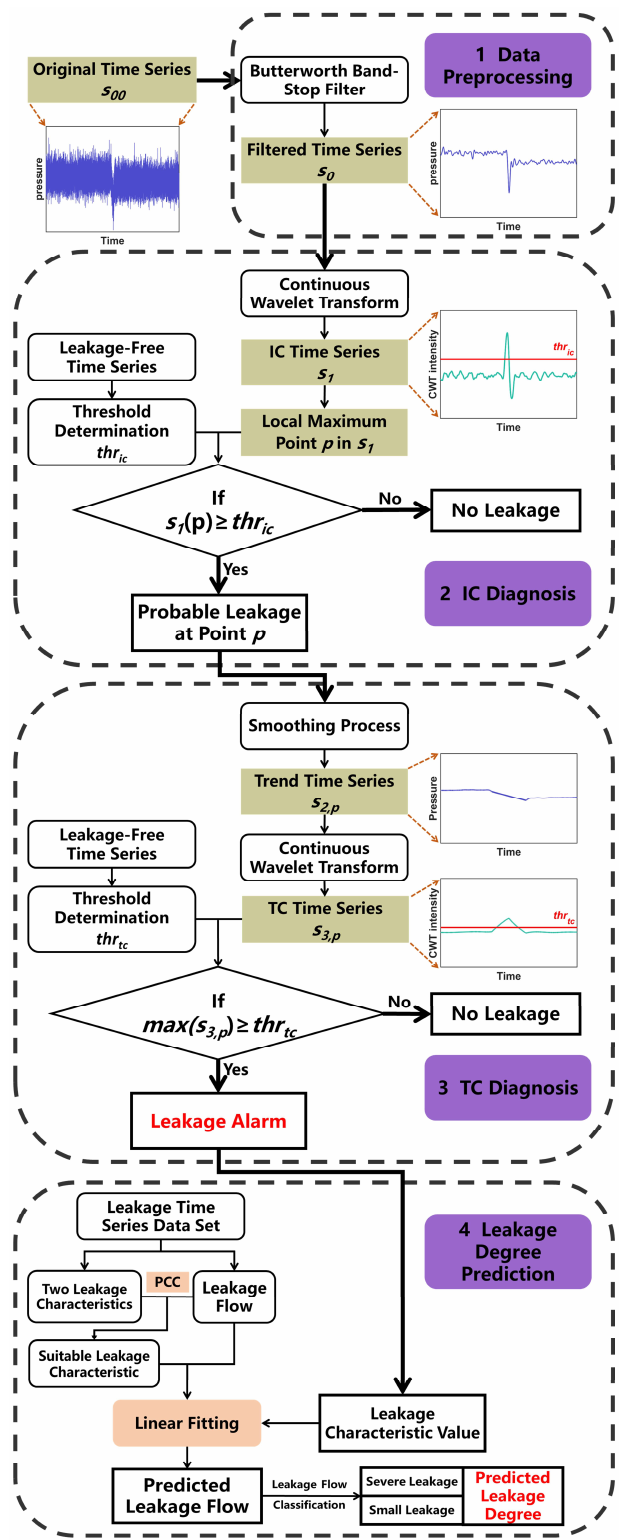
Figure 1. The framework of leakage detection.